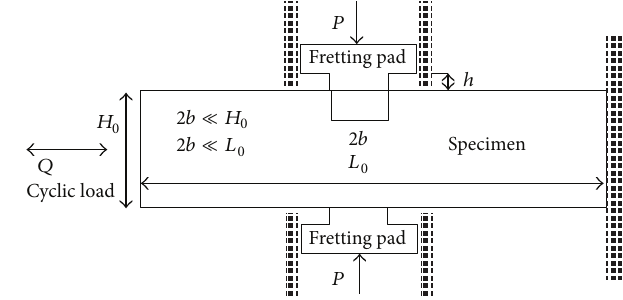
Figure 3: The schematic view of a fretting fatigue arrangement